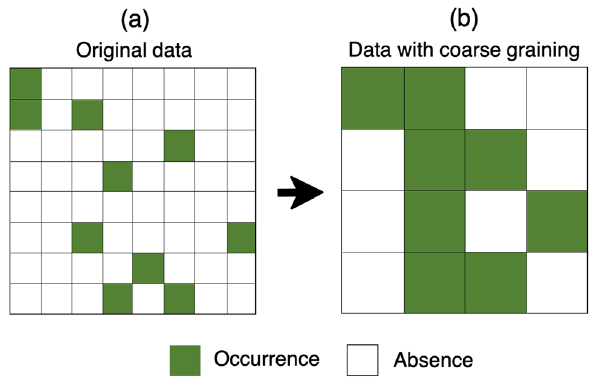
Fig. 3 Schematic explanation for the data resolution matching (DRM) method. This method requires the operation of converting the a original high-resolution data to b appropriate coarse- grained data for spatial conservation